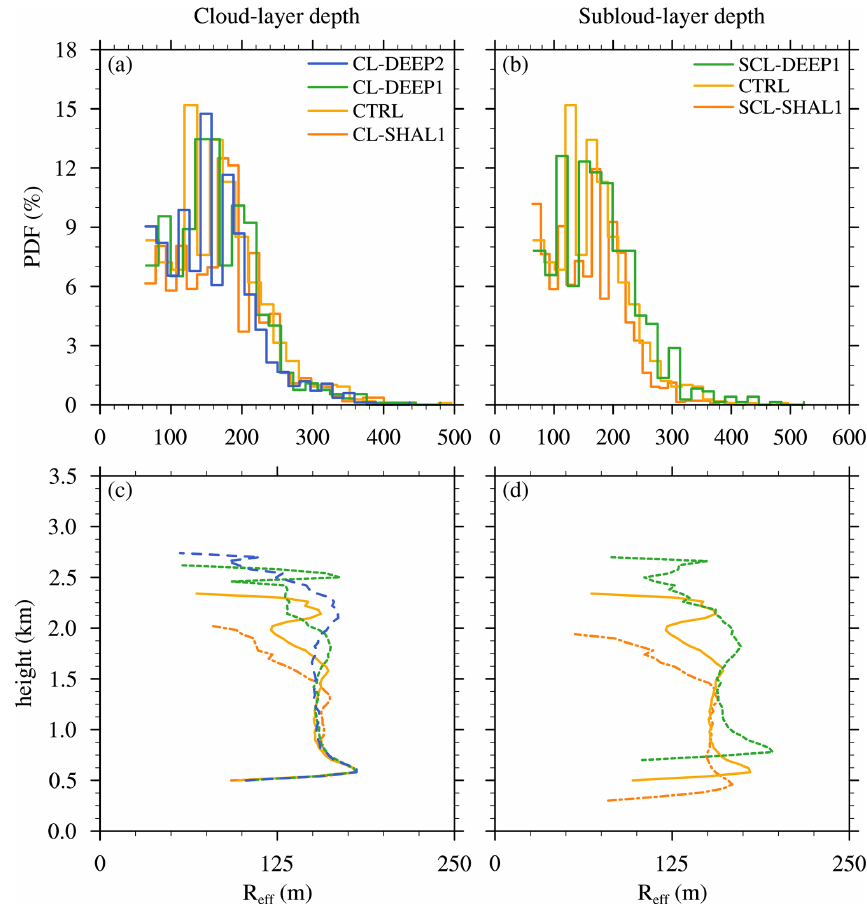
Figure 14. PDF of the effective cloud radius ( R eff ) halfway into the respective cloud layers for the experiments with (a) different cloud-layer depths and (b) varying subcloud-layer depths. The averaged R eff profile for the same experiments are shown in (c) and (d) , respectively.